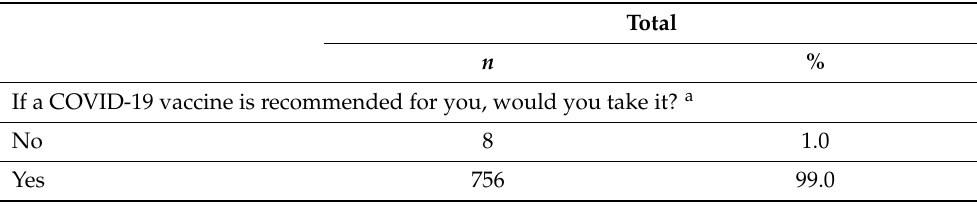
Table 8. Willingness to get vaccinated. a Number for each item may not add up to the total number of study respondents due to missing